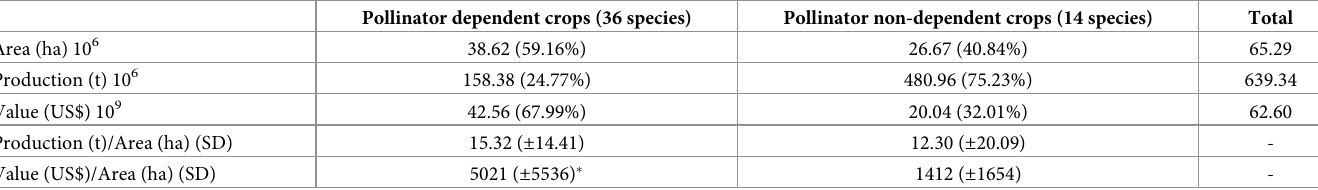
Table 2. Absolute and relative values of pollinator dependent and pollinator non-dependent crops in